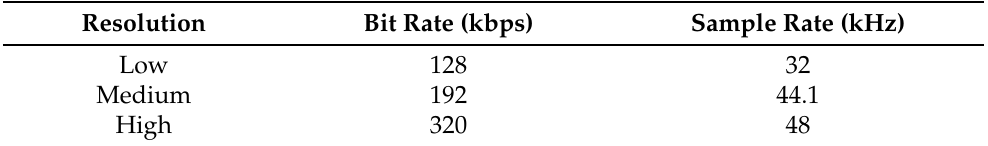
Table 2. High-level audio